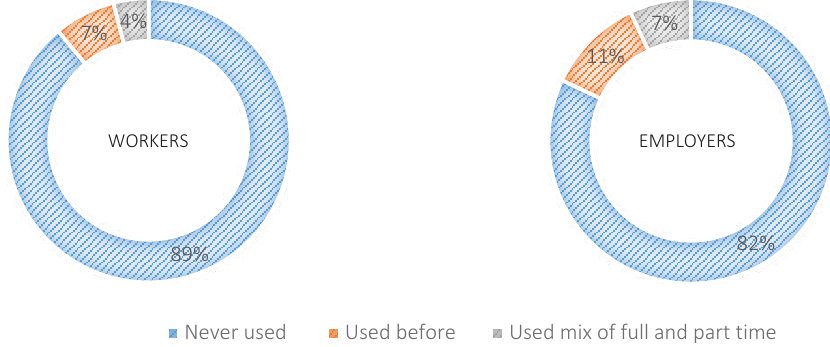
Figure 3. Previous experience of online